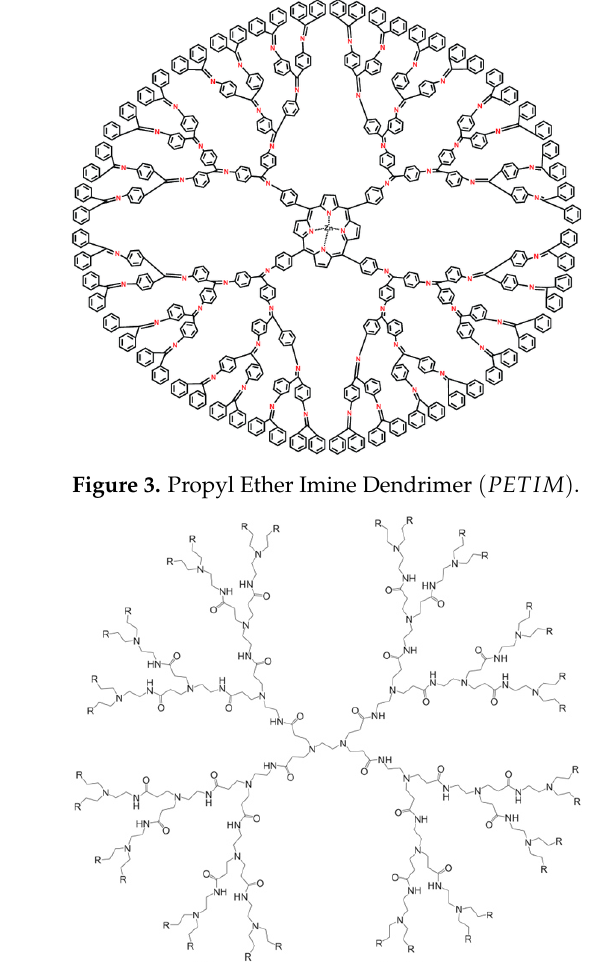
Figure 4. Poly(EThylene Amide Amine) Dendrimer PETAA